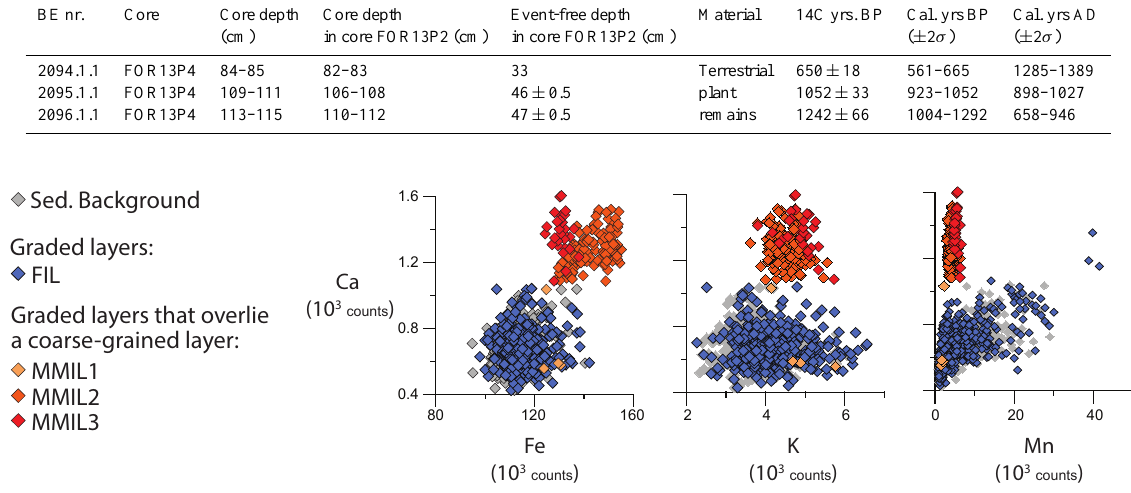
Figure 3. To illustrate the different geochemical characteristics of the sedimentary background and the graded layers, their Ca intensities were plotted against their Fe, K and Mn intensities. FIL refers to flood- and MMIL to mass-movement-induced layers. The different MMILs are labelled according to Fig.